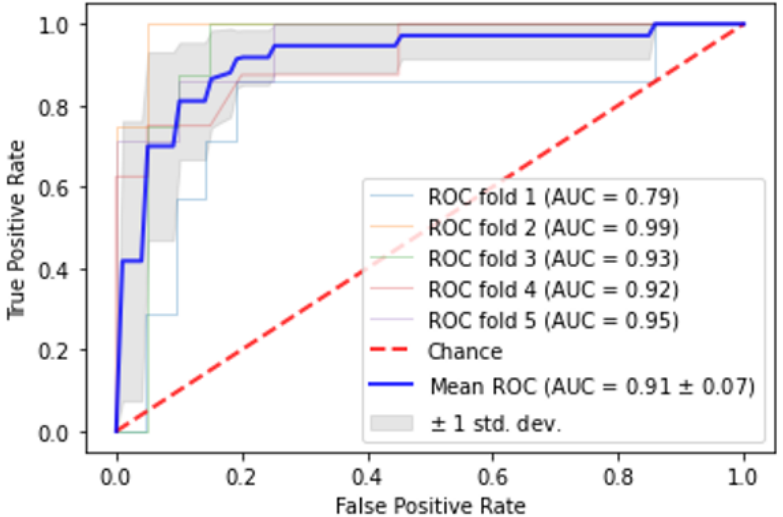
Figure 4. Area under the curve graph for random forest model trained in 5-fold cross-validation setting differentiating eyes requiring immediate anti-VEGF treatment from eyes not requiring treatment .